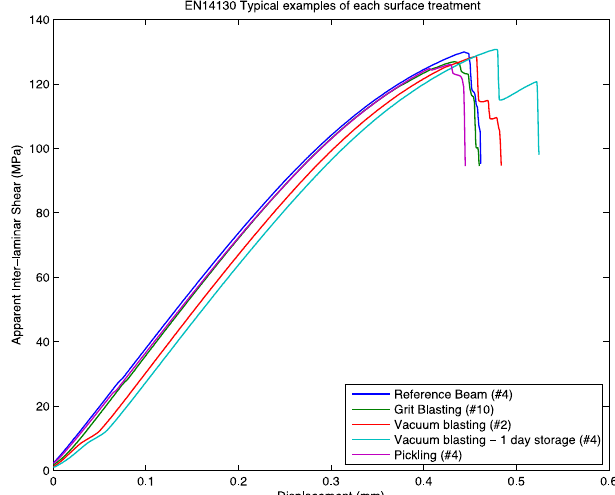
Figure 7: Plot of typical examples of Reference beam and Hybrid beam with vacuum